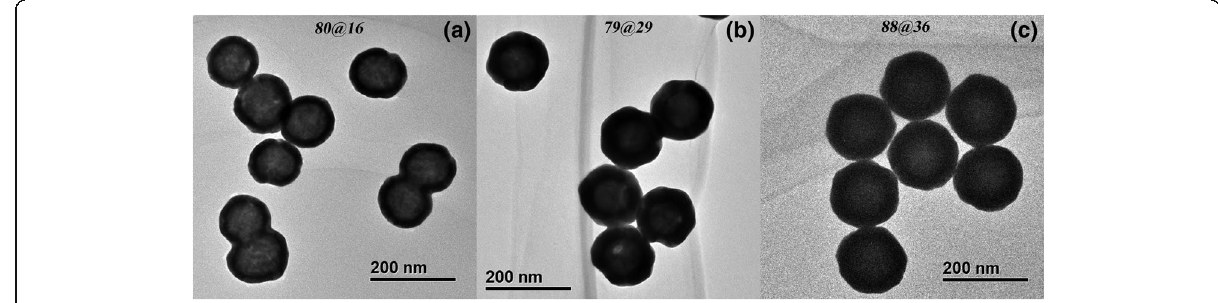
Fig. 3 TEM images of the three gold nanoshells used in experimental measurements. a 80-nm-diameter silica core, 16-nm-thick gold shell. b 79-nm-diameter silica core, 29-nm-thick gold shell. c 88-nm-diameter silica core, 36-nm-thick gold shell. The detailed characterization information is provided in supporting